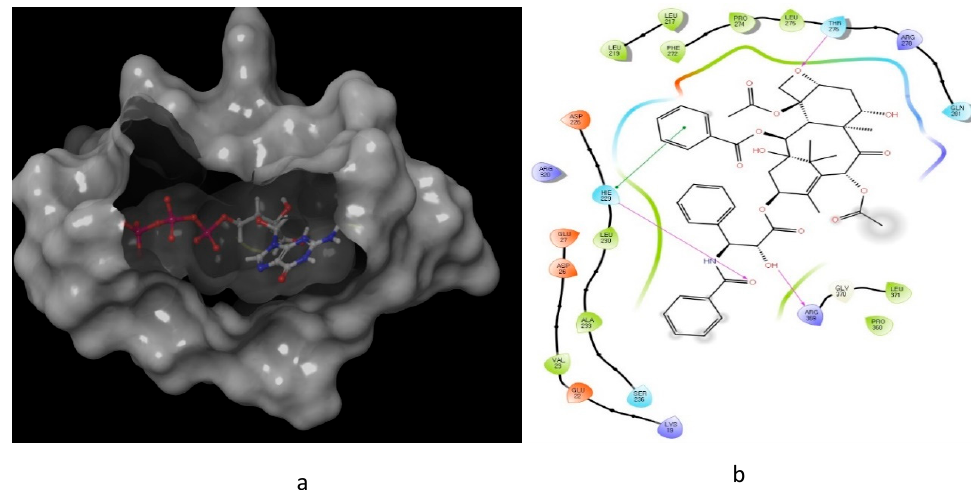
Figure 11. Predicted interaction of paclitaxel with microtubule active site residue [88,89]. ( a ) 3D structural view of the sulfonamide ligand inside the receptor’s active site. ( b ) Ligand interaction diagram; violet lines represent hydrogen bonds and green lines represent π – π interactions.